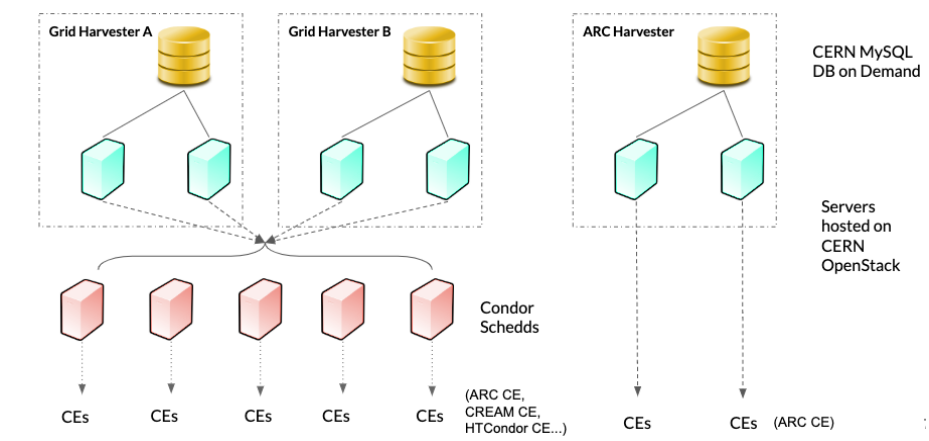
Fig. 1. Harvester infrastructure